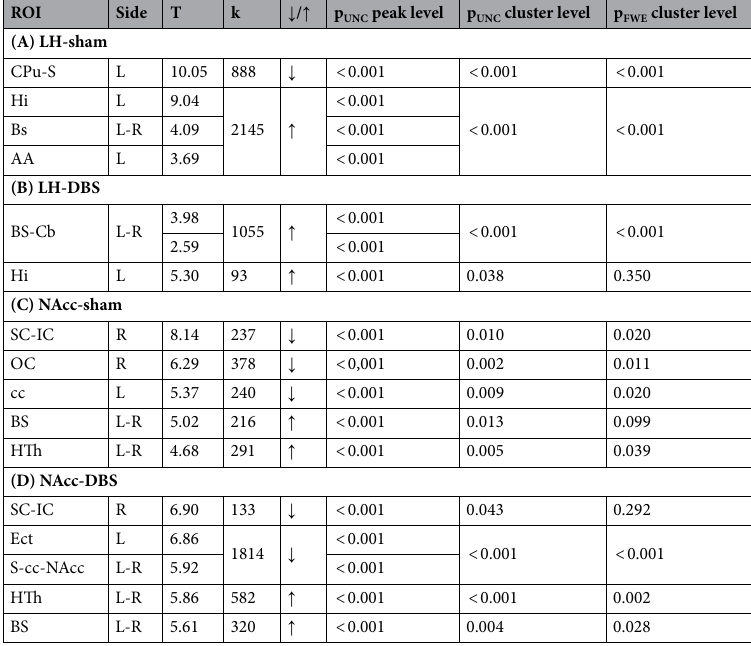
Table 1. Permanence of brain metabolic changes 1 month after stimulation. AA amygdala, BS brainstem, Cb cerebellum, cc corpus callosum, CPu caudate-putamen, Ect ectorhinal cortex, Hi hippocampus, HTh hypothalamus, IC inferior colliculus, LH lateral hypothalamus, NAcc nucleus accumbens, OC orbital cortex, Pit pituitary gland S somatosensory cortex, SC superior colliculus, ROI region of interest. Side: Right (R) and Left (L). T t value, k cluster size. Glucose metabolism: Increase ( ↑ ) and Decrease ( ↓ ). p UNC p value uncorrected, FWE family wise error